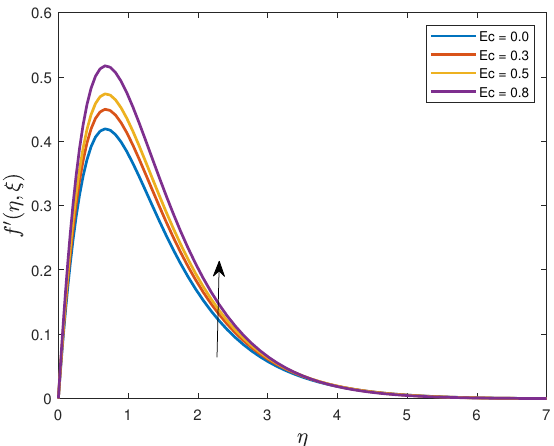
Figure 25. The influence of Ec on fluid velocity.